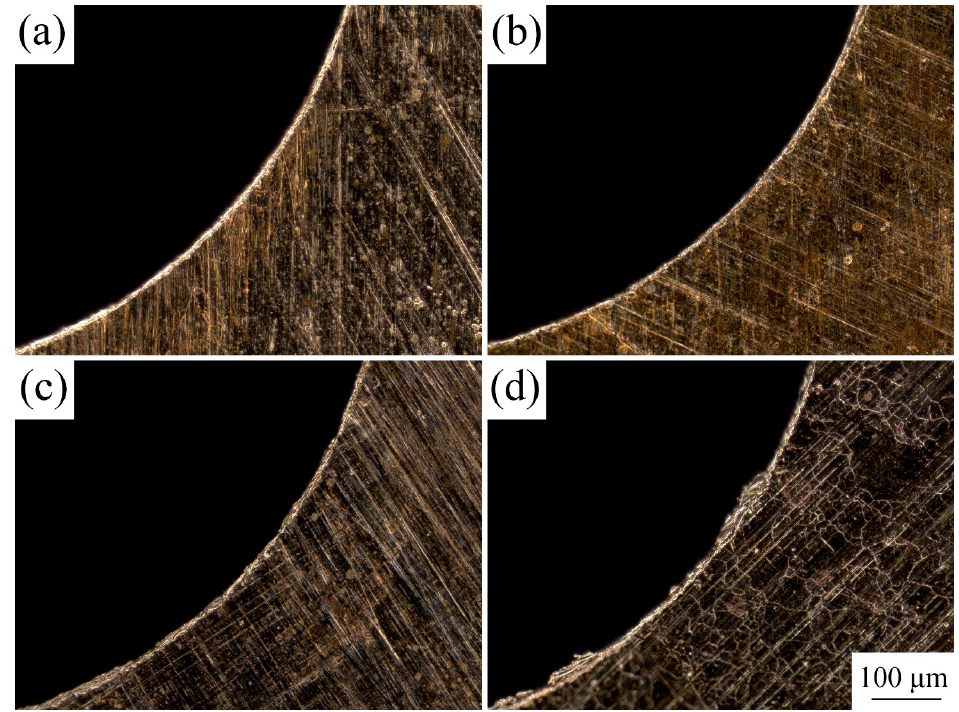
Figure 18. Comparison of punched holes without LPS under di ff erent conditions (bottom